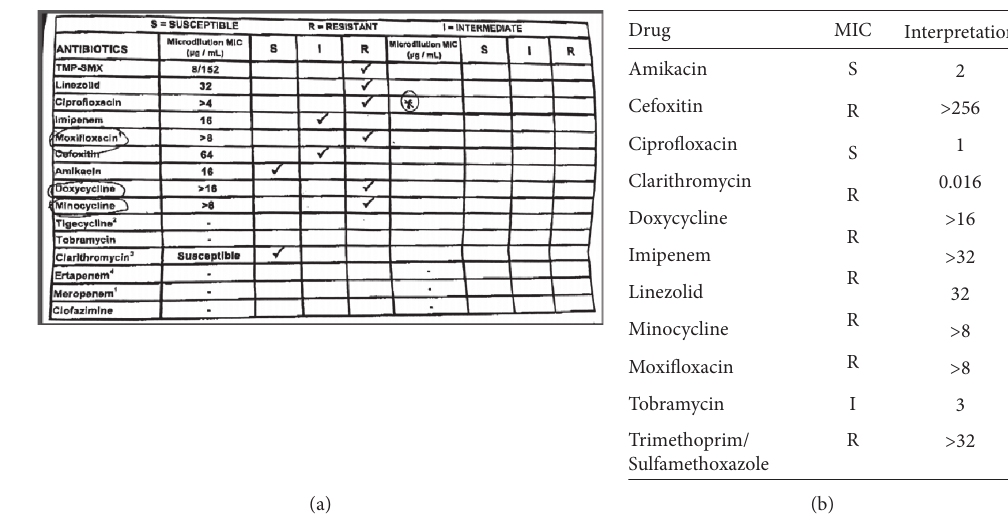
Figure 2: (a) Mycobacterium abscessus antibiotic susceptibilities for our patient as reported from UT Health Science Center at Tyler. (b) Patient’s M. abscessus antibiotic susceptibilities reported from local microbiology